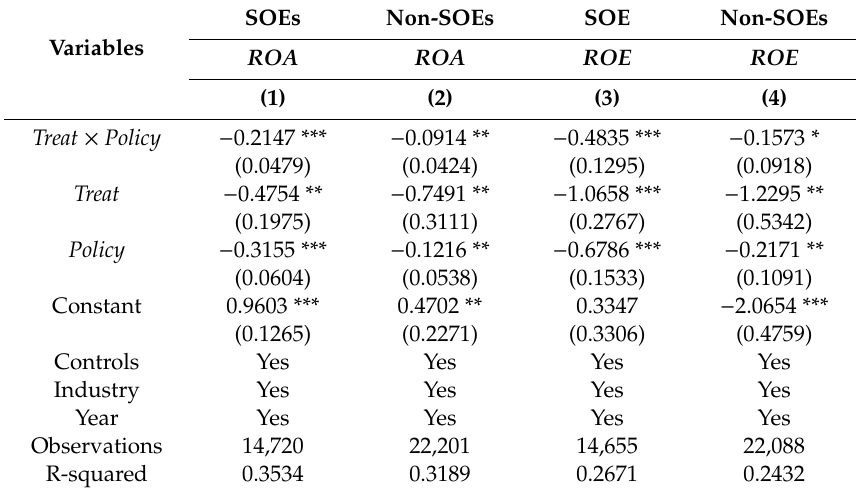
Table 4. Impacts of NEPL on the performance of SOEs and